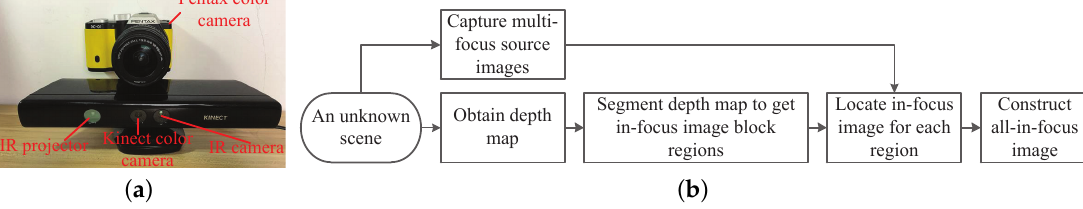
Figure 2. ( a ) Setup used in this work for evaluating the proposed multi-focus image fusion method. ( b ) Flowchart of the